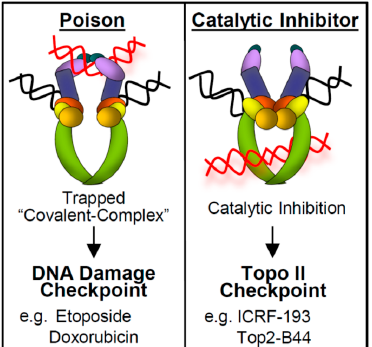
Figure 3. Comparison of Topoisomerase II (Topo II) poisoning ( left ) versus catalytic inhibition ( right ). DNA color scheme: Black helix (G-segment DNA); Red helix (T-segment DNA). Topo II domains: N-gate (purple/blue); DNA-binding catalytic core (orange/yellow/red); C-gate (green).